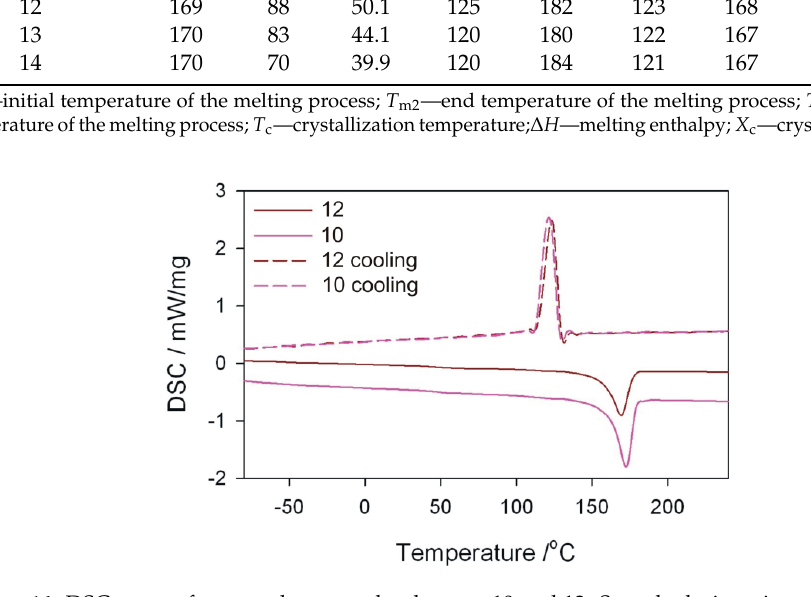
Figure 14. DSC curves for extrudate samples–layouts 10 and 12. Sample designations as in Table 1.